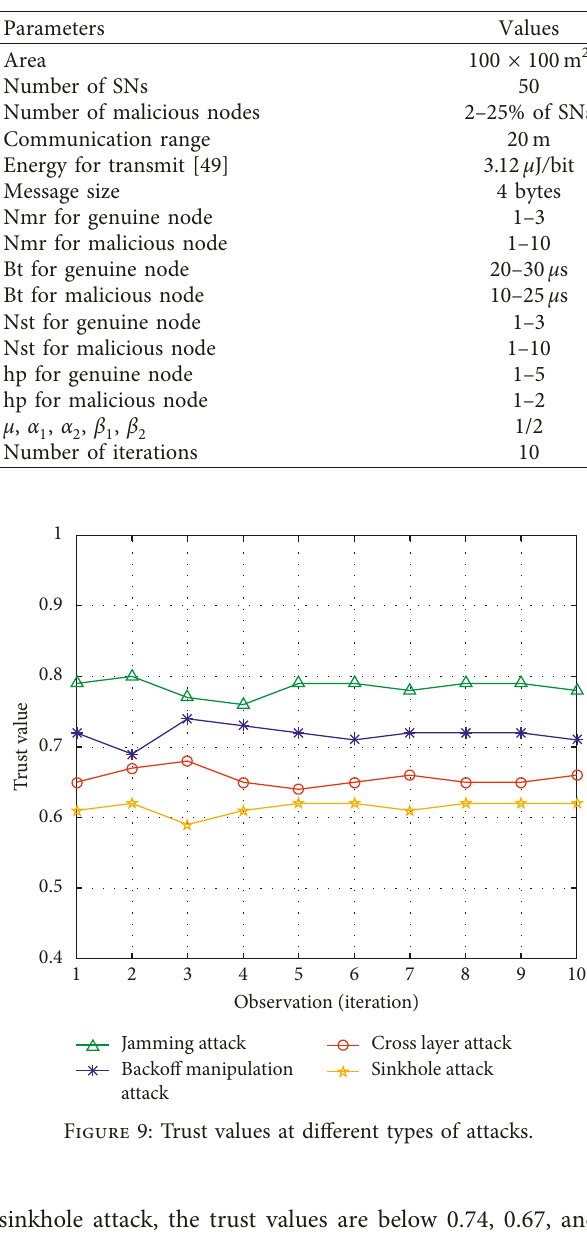
Table 2: Simulation setup.